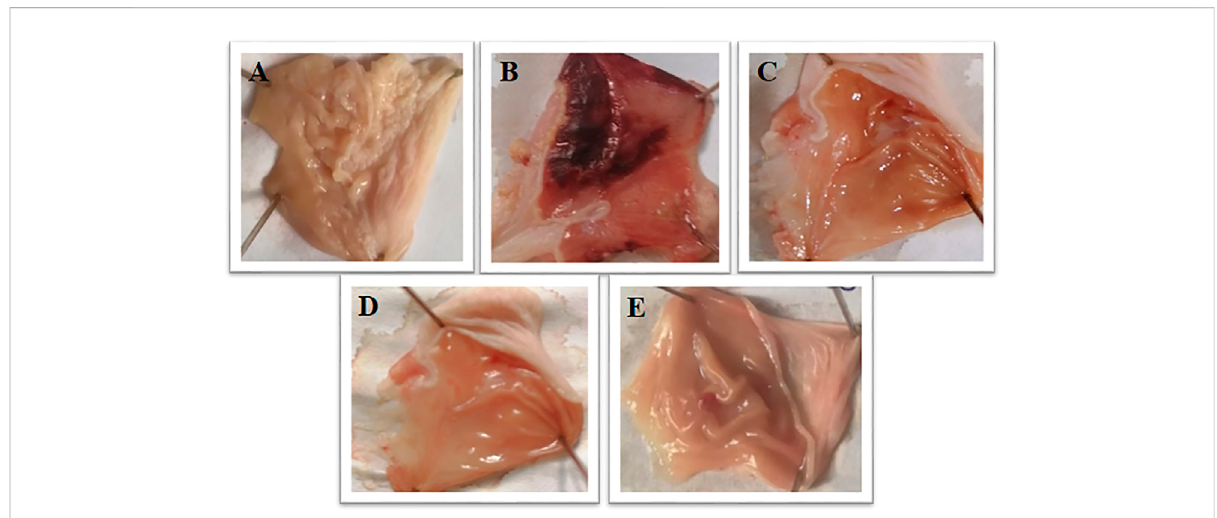
FIGURE 2 Gross appearance of gastric mucosa in rats: (A) pretreated with saline, (10 mL/kg). (B) Severe injuries are seen, extensive visible hemorrhagic necrosis of gastric mucosa was produced by absolute ethanol (1 mL/100g), (C, D) pretreated with brucine at doses of 1 and 3 mg/Kg, and (E) pretreated with omeprazole 20